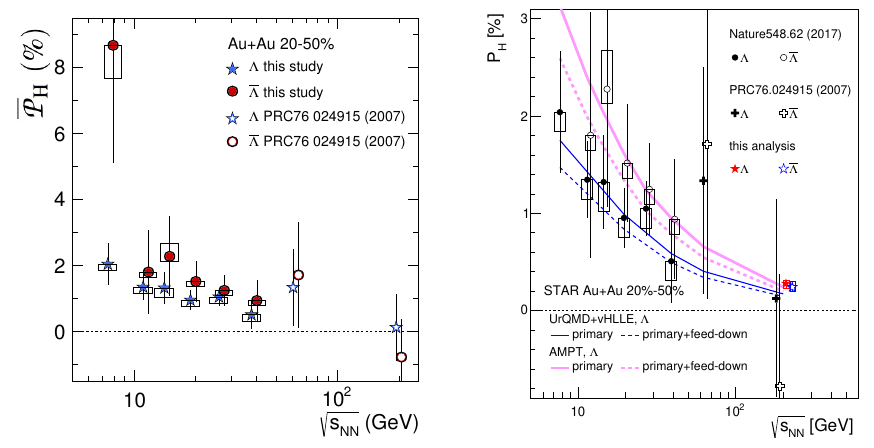
Figure 4. Global polarization ¯ P H (where H = Λ or ¯ Λ ) of Λ and ¯ Λ as a function of the collision √ s NN for 20-50% centrality Au + Au collisions. Left. The results of the measurements for BES energy √ s NN < 40 GeV) are compared with the data previously calculated for 62.4 and 200 GeV energy range ( collisions, for which only statistical errors are plotted. Boxes indicate systematic uncertainties. Right. Thin lines show calculations from a (3 + 1)D cascade + viscous hydrodynamic model (UrQMD + vHLLE) [10] and bold lines show the AMPT model calculations [11]. In the case of each model, primary Λ with and without the feed-down e ff ect are indicated by dashed and solid lines, respectively. Open boxes and vertical lines show systematic and statistical uncertainties, respectively. Data points at 200 GeV and for ¯ Λ are slightly horizontally shifted for